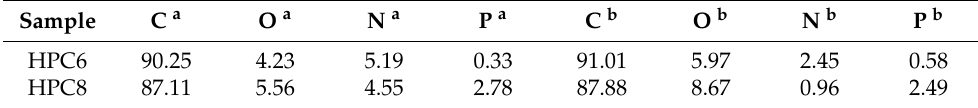
Figure 2. Nitrogen sorption isotherms ( a ), carbon dioxide sorption isotherms (inset in a) and their corresponding pore size distributions ( b ) for HPC6 and HPC8.